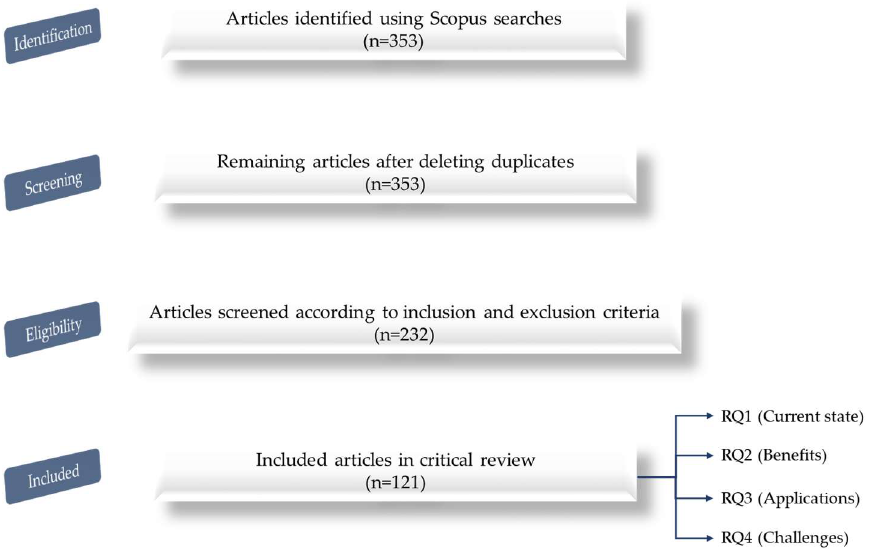
Figure 2. Diagram of research method.